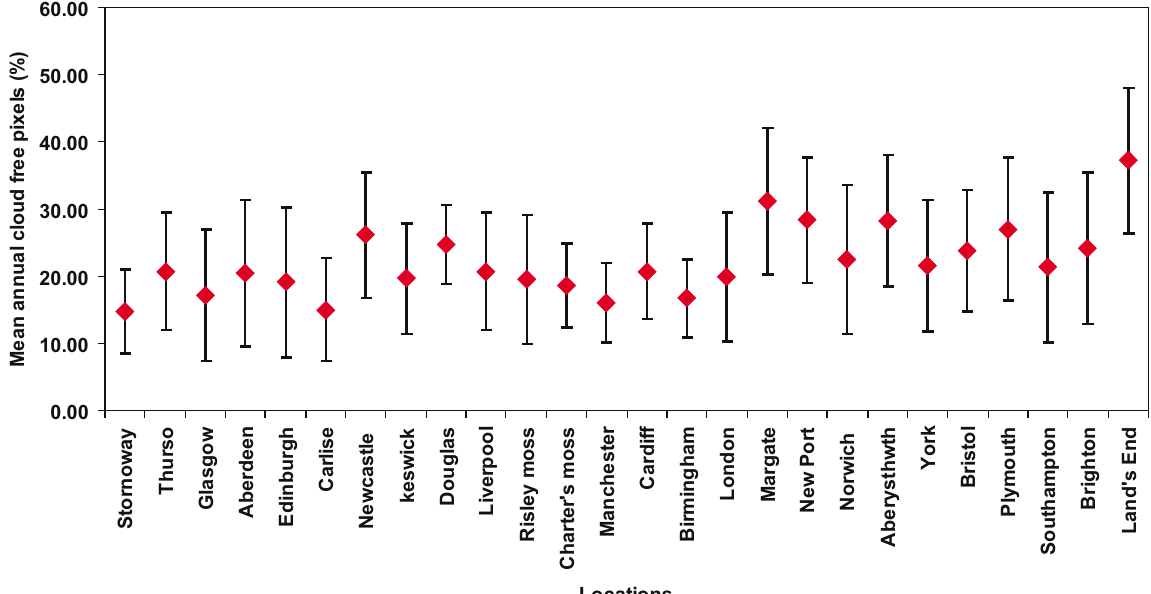
Fig. 5. One year clear pixels and standard deviation of selected locations in the UK